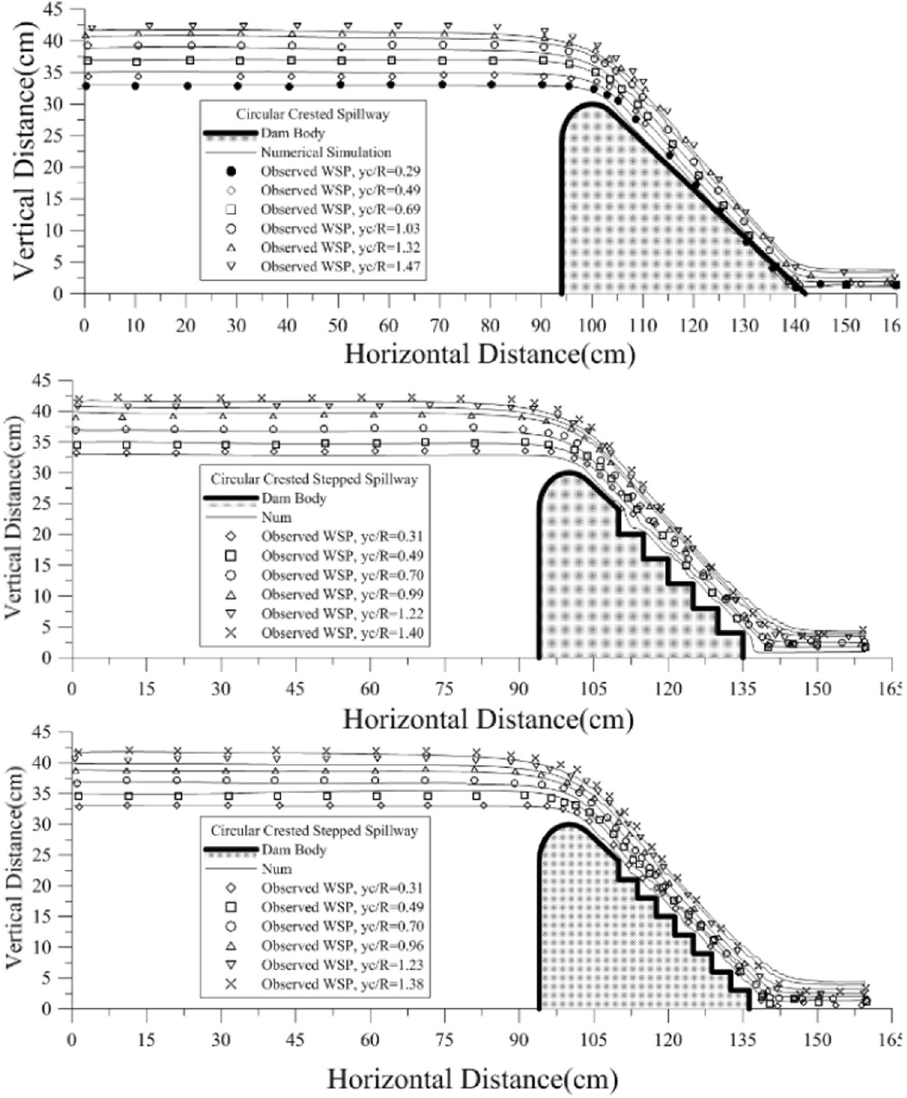
Fig. 2 The results of the meas- ured water surface profile and the numerical